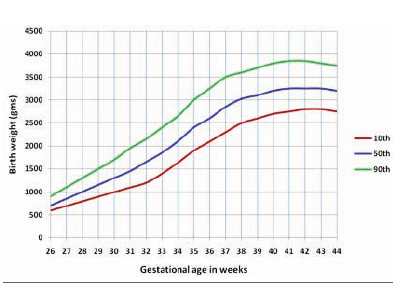
Figure 1. Birth weight for gestational age curves in a population of Nigerian new- borns.